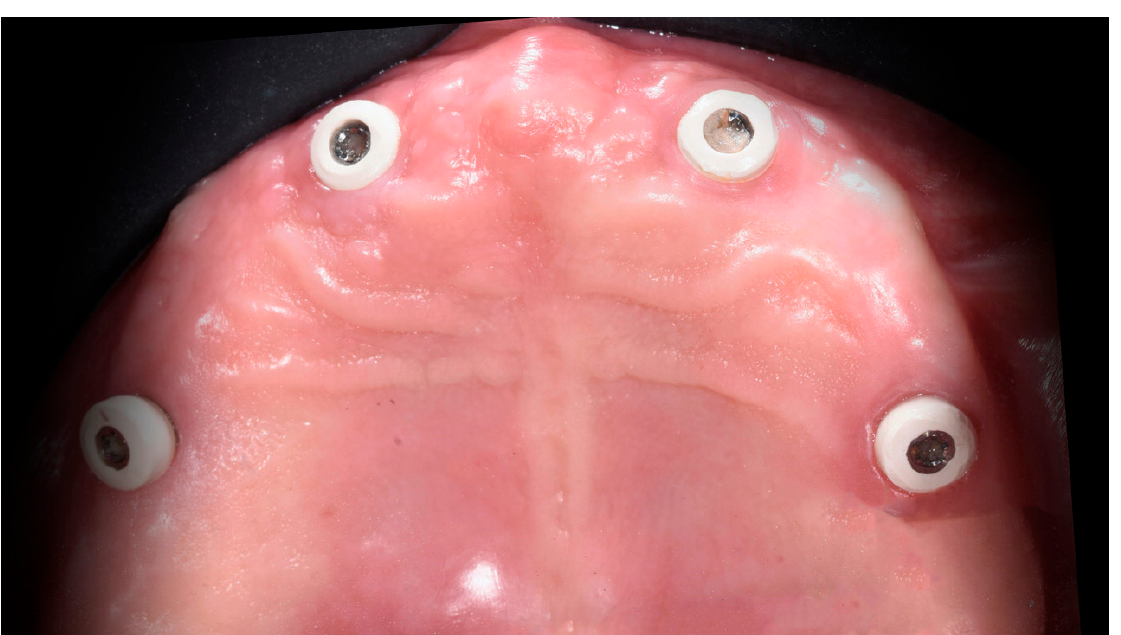
Figure 3. Implants with healing abutments screwed.